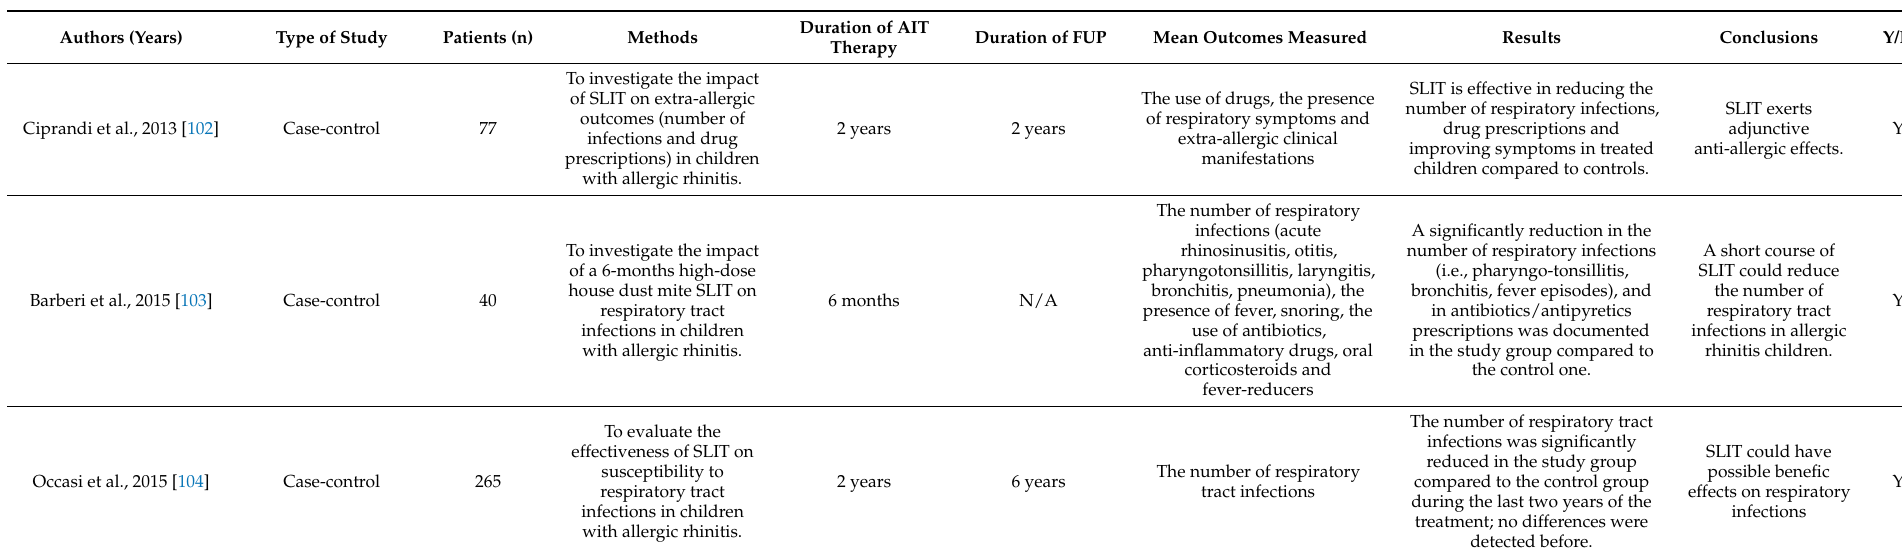
Table 3. Studies on efficacy of AIT in adenotonsillar